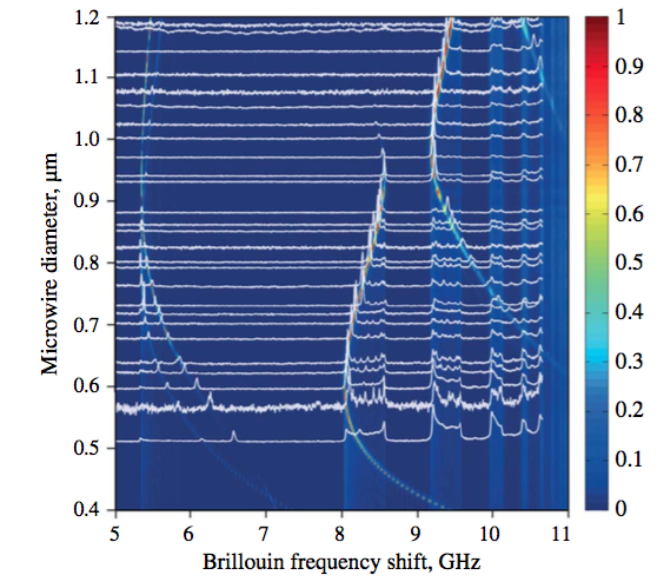
Figure 7. Mapping of the experimental surface Brillouin spectrum with the numerically-calculated responses to detect the core diameter of the microfibre under fabrication [103]. Reprinted with permission from [103],